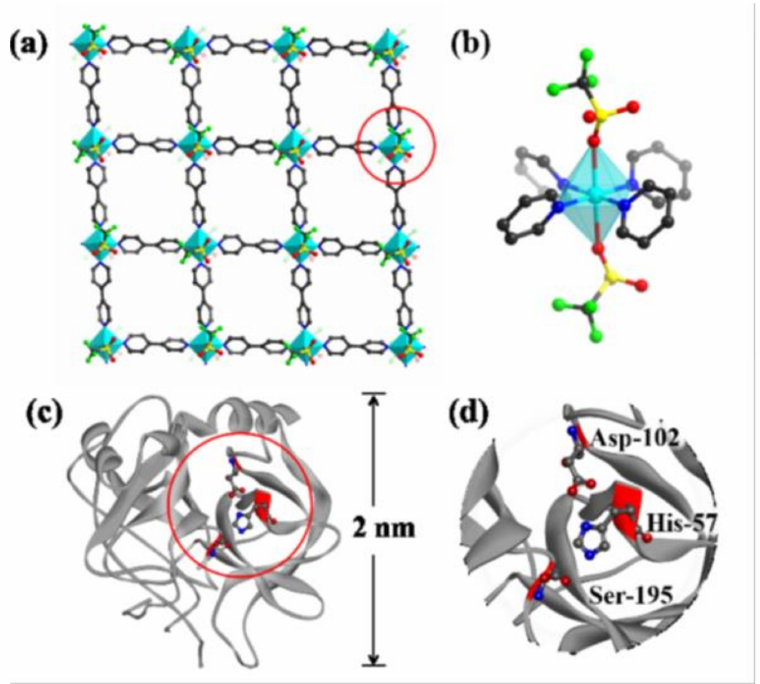
Figure 6. ( a ) Schematic representation of a single-layered 2D nanosheet of Cu-MOF. Color code: C, gray. O, red. S, yellow. F, green. Cu polyhedral, blue. H-atoms not shown. ( b ) Schematic representation of a Cu(II) center in the nanosheets. ( c ) Molecular structure of a -chymotrypsin. ( d ) The polychrome sections in this structure are the active site with residues Asp-102, His-57, and Ser-195. a -chymotrypsin can be effectively inhibited by 2D Cu-MOF, [Cu(bpy)OTf) 2 ] (bpy = 4,4 (cid:48) -bipyridine, OTf = trifluoromethanesulfonate). Reprinted with permission from J. Am. Chem. Soc., 2017, 139, 8312–8319 ([189]). Copyright 2018 American Chemical